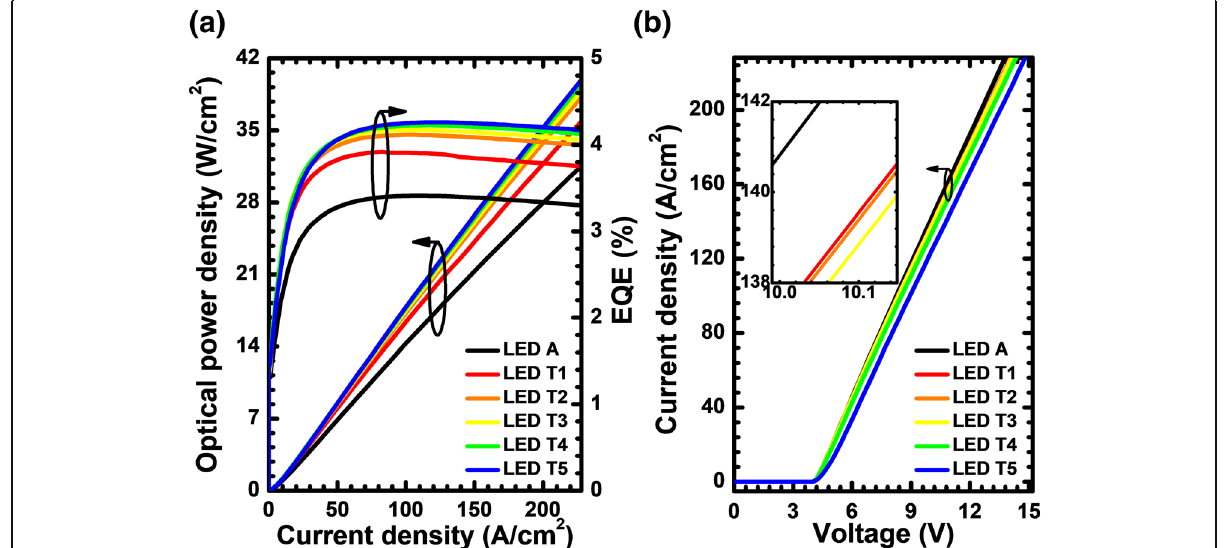
Fig. 7 a Optical output power density, b current-voltage characteristics for LEDs A, T1, T2, T3, T4, and T5. Inset figure shows the zoom-in current-voltage